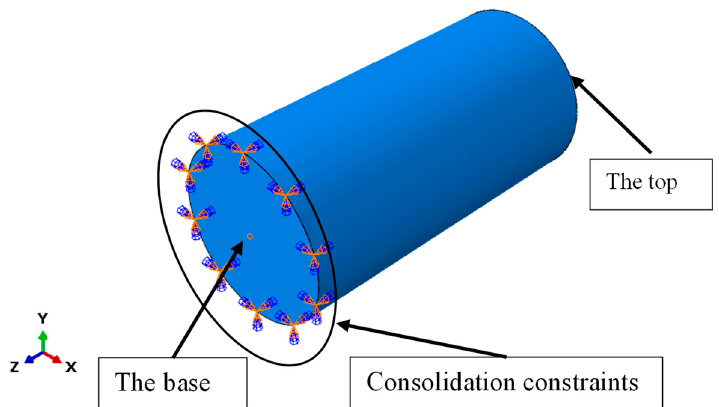
Figure 14. Boundary conditions and orientation of the model. Table 6. Material parameters.